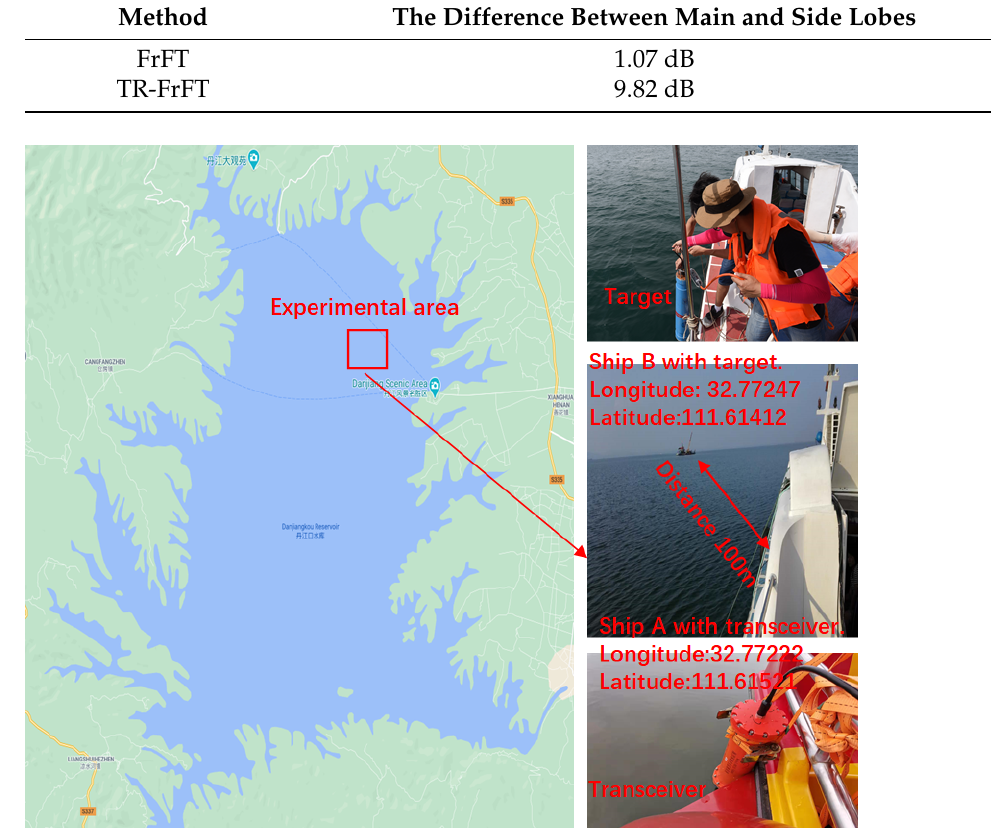
Table 3. The comparison results of FrFT and TR-FrFT with simulated data.